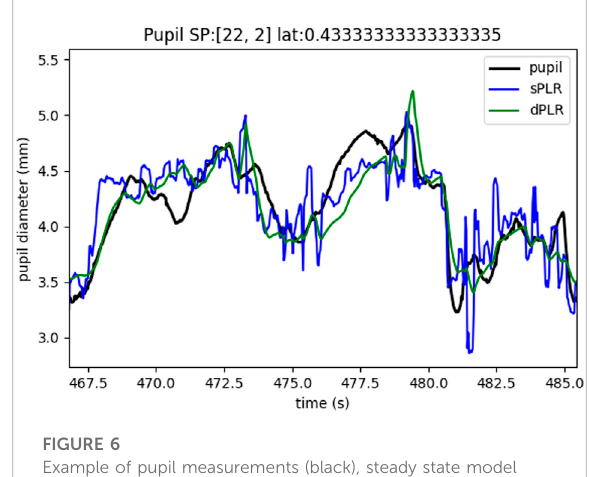
FIGURE 4 Pearson correlation coef fi cient of luminance with the: measured pupil, arousal indicator, PLR using exponential model (sPLR), PLR using dynamic model (dPLR). All the correlation distributions are statistically signi fi cantly different from each other (paired Wilcoxon test with p-value less than 0.001).